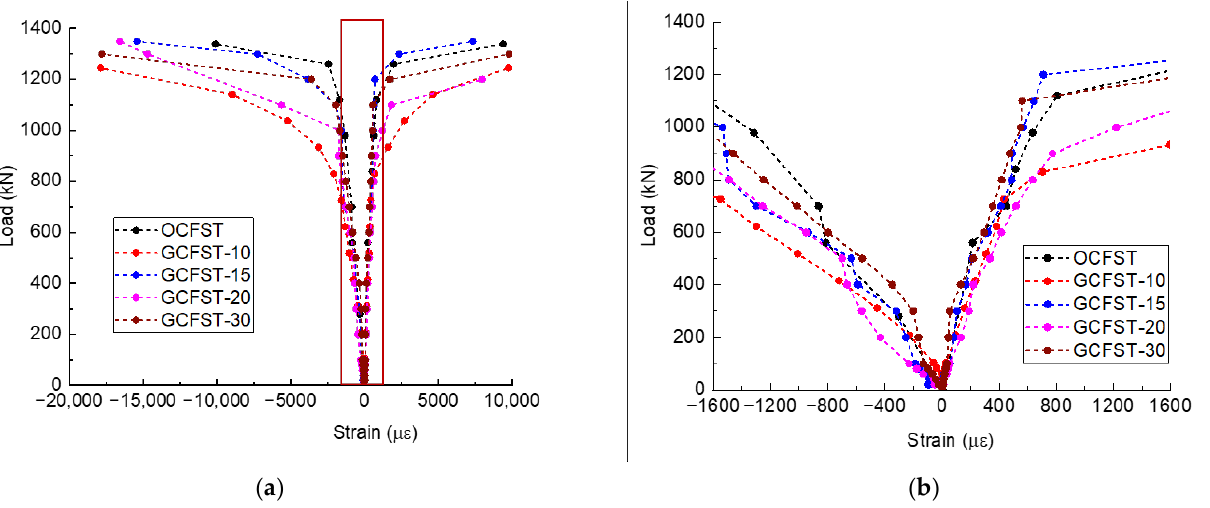
Figure 11. Load–strain (both axial and lateral strain) relationship for tubular specimens with different concrete mixtures: ( a ) load–strain response during the whole loading process; ( b ) load–strain response prior to the yield strain of the steel (enlarged view of the selected region shown in ( a )).